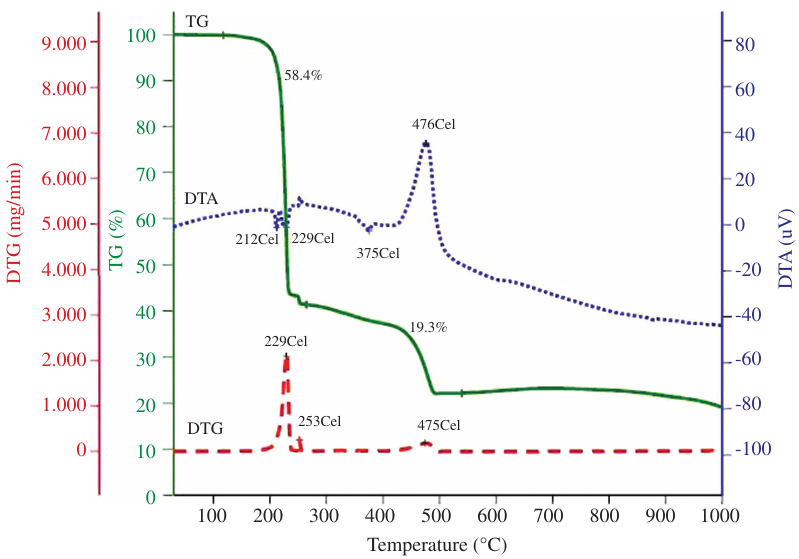
Figure 8 Thermal analyses curves of the Cu complex.